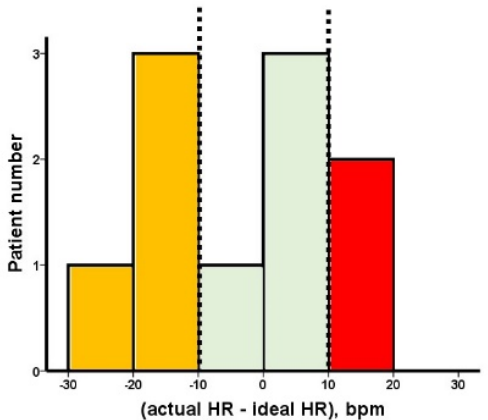
Figure 3. Distribution of the difference between actual HR and ideal HR. Yellow bars indicate the lower HR group: (actual HR − ideal HR) < − 10 bpm. Blue bars indicate optimal HR group: − 10 bpm ≤ (actual HR − ideal HR) ≤ 10 bpm. Red bars indicate the higher HR group: (actual HR − ideal HR) > 10 bpm. HR; heart rate.